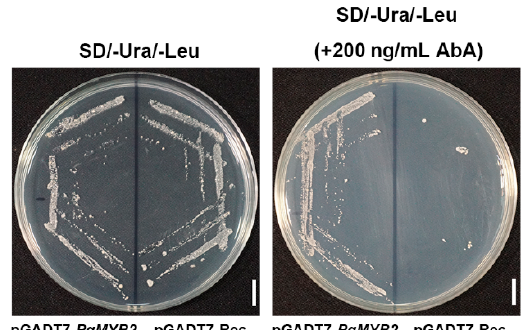
Figure 5. The interaction of PgMYB2 and DDSpro in Y1H Gold. As shown in the left half of the plate, only the yeast cells with pGADT7-PgMYB2 were able to grow on the SD / − Ura / − Leu selective medium added with 200 ng / mL AbA. Scale bar = 1 cm.